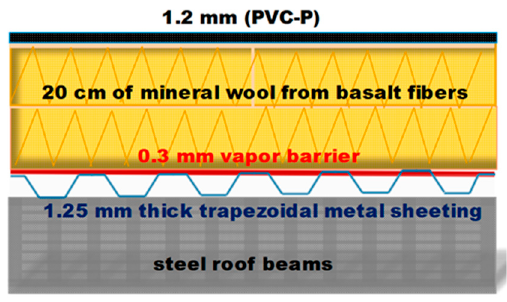
Figure 1. Scheme of the roofing